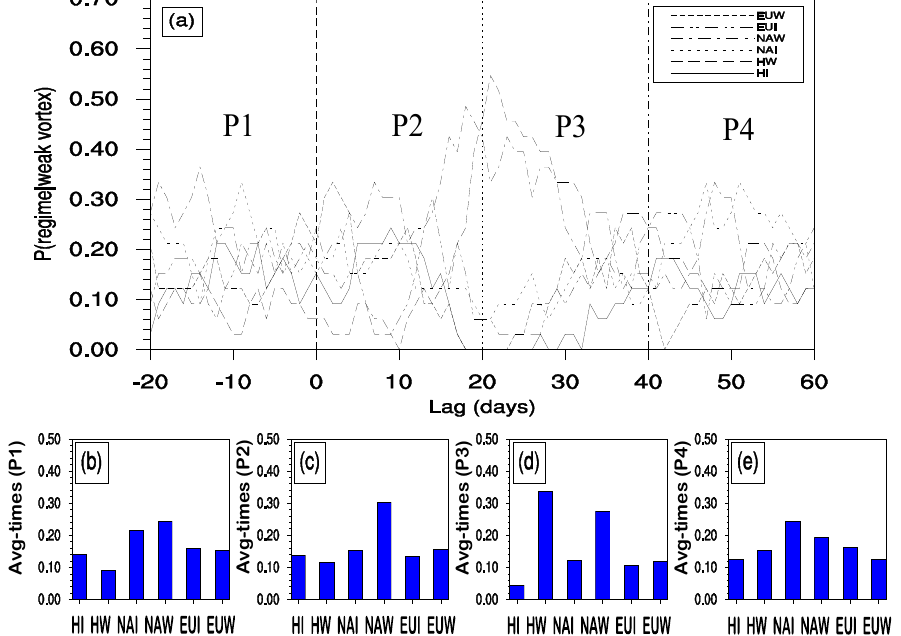
Figure 8. ( a ) The occurrence frequency statistics for the six stratospheric Arctic vortex weather regimes within days -20 to 60 with respect to the SSW occurrence date based on three historical runs.